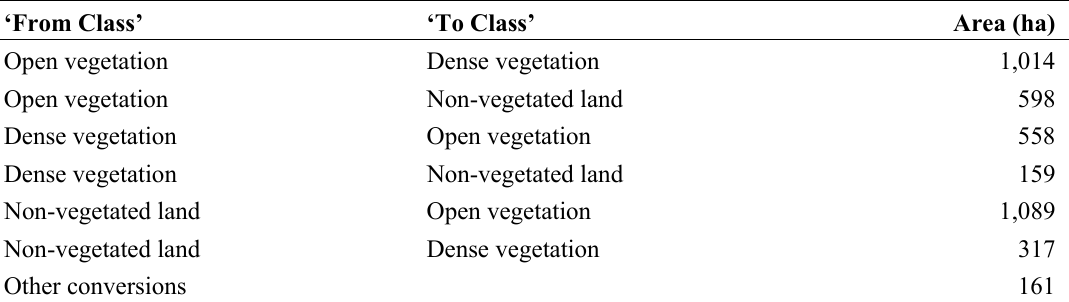
Table 5. Major vegetation covers conversions,